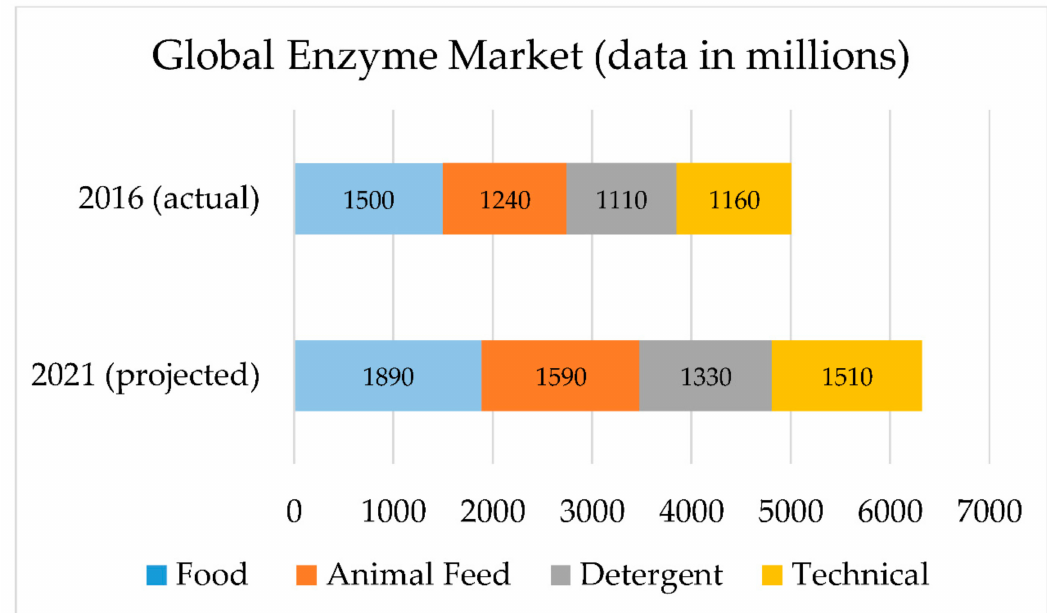
Figure 1. Global enzyme market in 2016 (top) and projected global enzyme market in 2021 (bottom). Figure adapted from data included in Ref. [44].